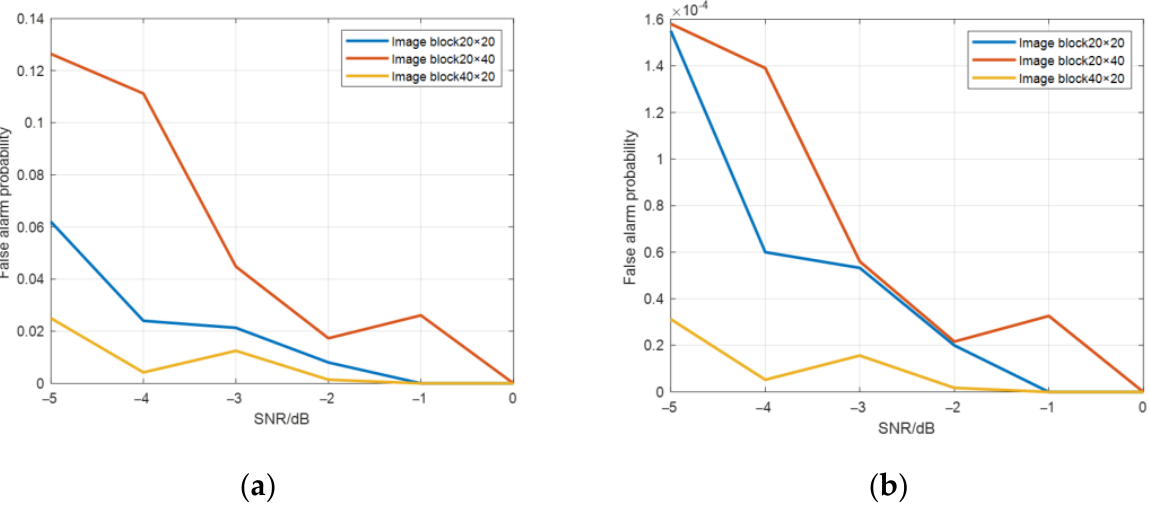
Figure 20. False alarm probability graphs of ( a ) the whole image and ( b ) a single point with different image block sizes.